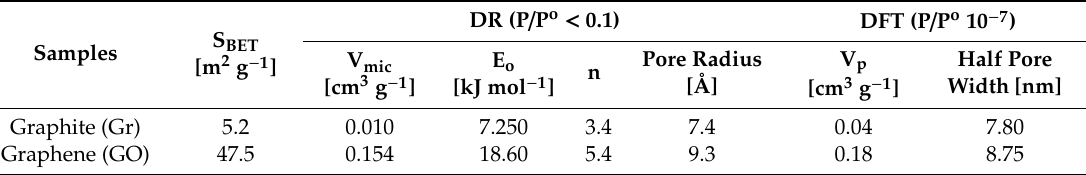
Figure 2. N 2 gas adsorption-desorption isotherms of samples and pore size distribution (PSD) calculated with quenched solid density functional theory (QSDFT) kernel: ( a ) graphite (Gr) ( b ) graphene oxide (GO) ( c ) Simulation of Gr with non-local density functional theory (NLDFT) and QSDFT ( d ) Simulation of GO with NLDFT and QSDFT [86]. Table 2. DR and DFT parameters obtained from the adsorption-desorption isotherms of N 2 at − 196 ◦ C